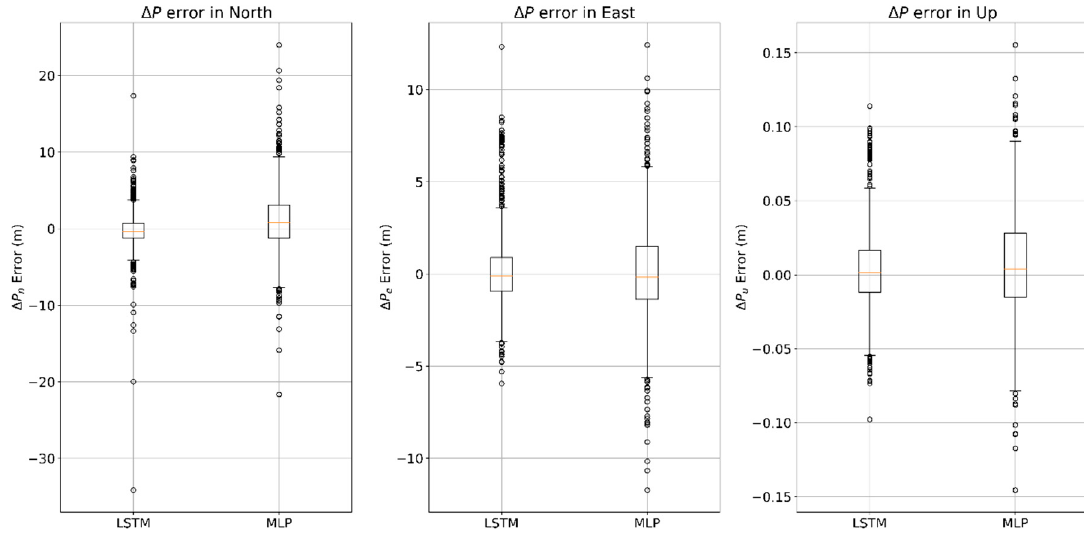
Figure 11. Comparison of multilayer perceptron neural network (MLP) and LSTM algorithms in terms of prediction ∆ P error. Table 4. Mean abstract error and standard deviation of ∆ P in di ff erent algorithms.